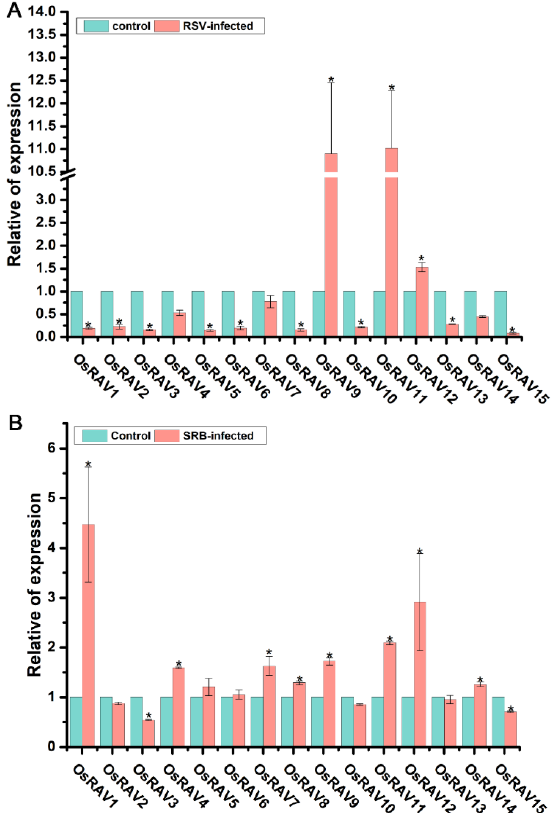
Figure 8. Relative expression level of fifteen RAV genes in response to RSV ( A ) and SRBSDV ( B ) infection. RNA was extracted from RSV-infected plants at 30 dpi and from SRBSDV-infected plants at 90 dpi. qPCR data are shown as relative expression levels of virus-infected plants in comparison with the mock control plants and normalized using OsUBQ5 . Results are the means ± standard deviation (SD) of three biological replicates. * indicates significant difference between virus free and infected at p ≤ 0.05 by Fisher’s least significant difference